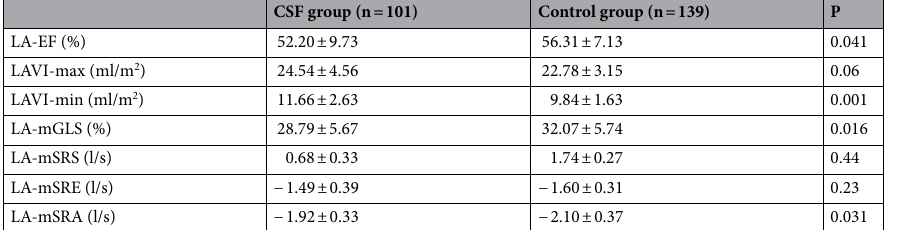
Table 6. Comparison of LA 2D-STE in CSF Group and control group. Values shown are means ± SD or percentages. LA-EF left atrial ejection fraction, LAVI-max maximum volume index of left atrium, LAVI-min minimum volume index of left atrium, LA-mGLS average global longitudinal strain of left atrium, LA-mSRS left atrial longitudinal strain rate (systolic), LA-mSRE left atrial longitudinal strain rate (early diastolic), LA-mSRA left atrial longitudinal strain rate (late